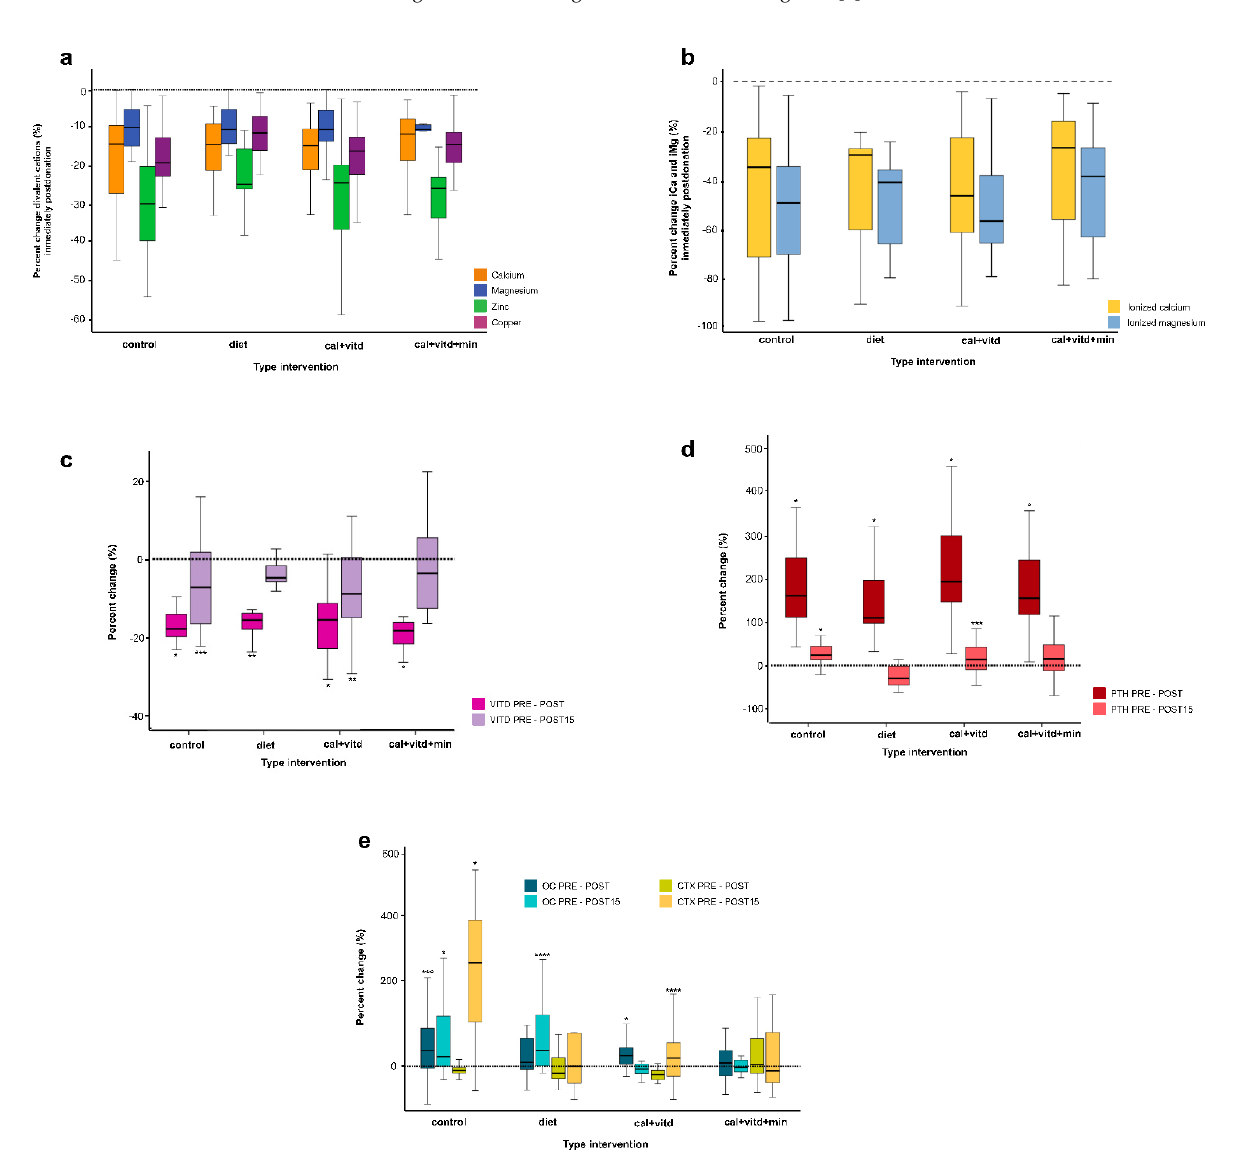
Figure 2. Effect of citrate on the plasma levels of total divalent cations ( a ), ionized cations ( b ), hormones ( c , d ), and bone turnover markers ( e ) in plateletpheresis donors at different times of the study. VITD: 25-OH Vitamin D, PTH: Parathyroid hormone; OC: Osteocalcin; CTX: C-terminal telopeptide of collagen type; CONTROL: No supplementation; DIET: Calcium-rich diet; CAL-VITD: Supplementation with calcium carbonate + vitamin D; CAL + VITD + MIN: Supplemented with calcium carbonate + minerals + vitamin D. The dotted line represents the basal state. PRE-POST: changes in serum post-donation levels compared to pre-donation levels. PRE-POST15: changes in serum levels 15 days after plateletpheresis compared to pre-donation levels. The results show statistical differences by Wilcoxon. * p ≤ 0.001, ** p ≤ 0.005, *** p ≤ 0.010, **** p ≤ 0.050.